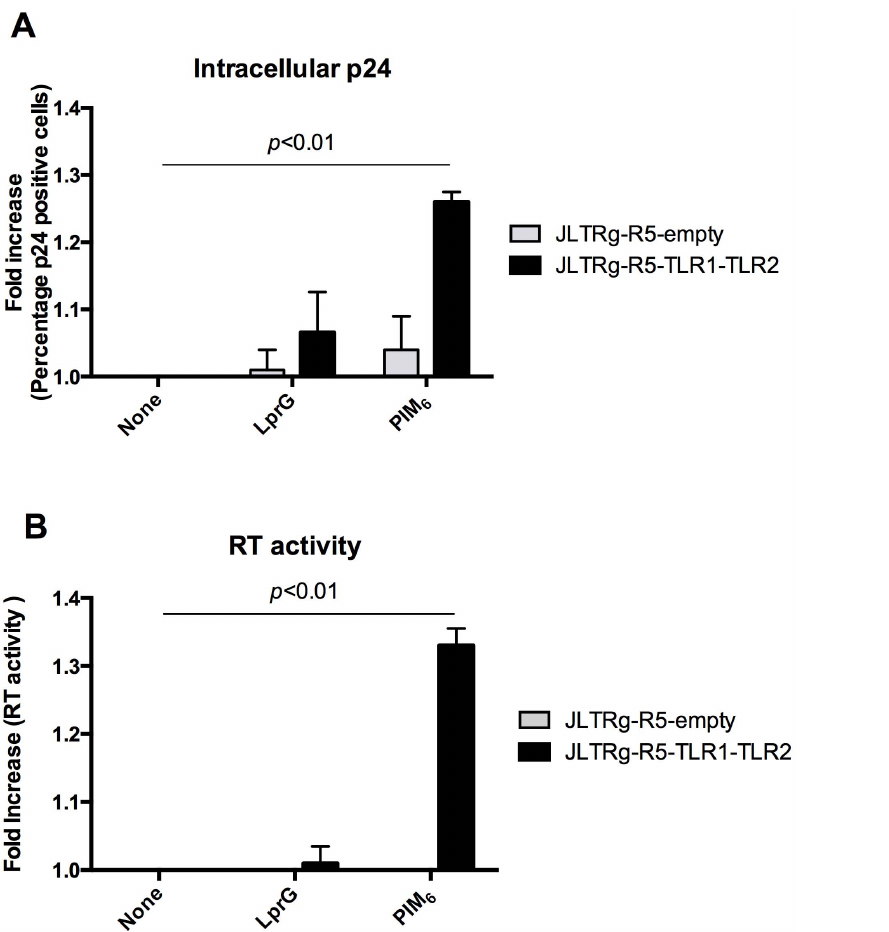
Figure 6. PIM 6 up-regulates HIV-1 infection via TLR2. JLTRg-R5-TLR1-TLR2 and JLTRg-R5-empty were activated overnight with a -CD3 in medium alone (None) or medium containing LprG (LprG) or PIM 6 (PIM 6 ). Cells were then infected with NLAD8 virus for 72 h and viral replication determined by measuring intracellular p24 by flow cytometry ( A ) or RT activity in culture supernatants ( B ). (A) Shown are means 6 SD of four independent experiments. (B) Shown are means 6 SD of two independent experiments in triplicate.